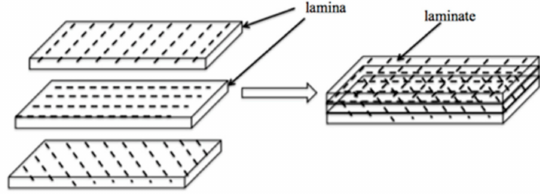
Figure 2. A laminate formed by stacking single